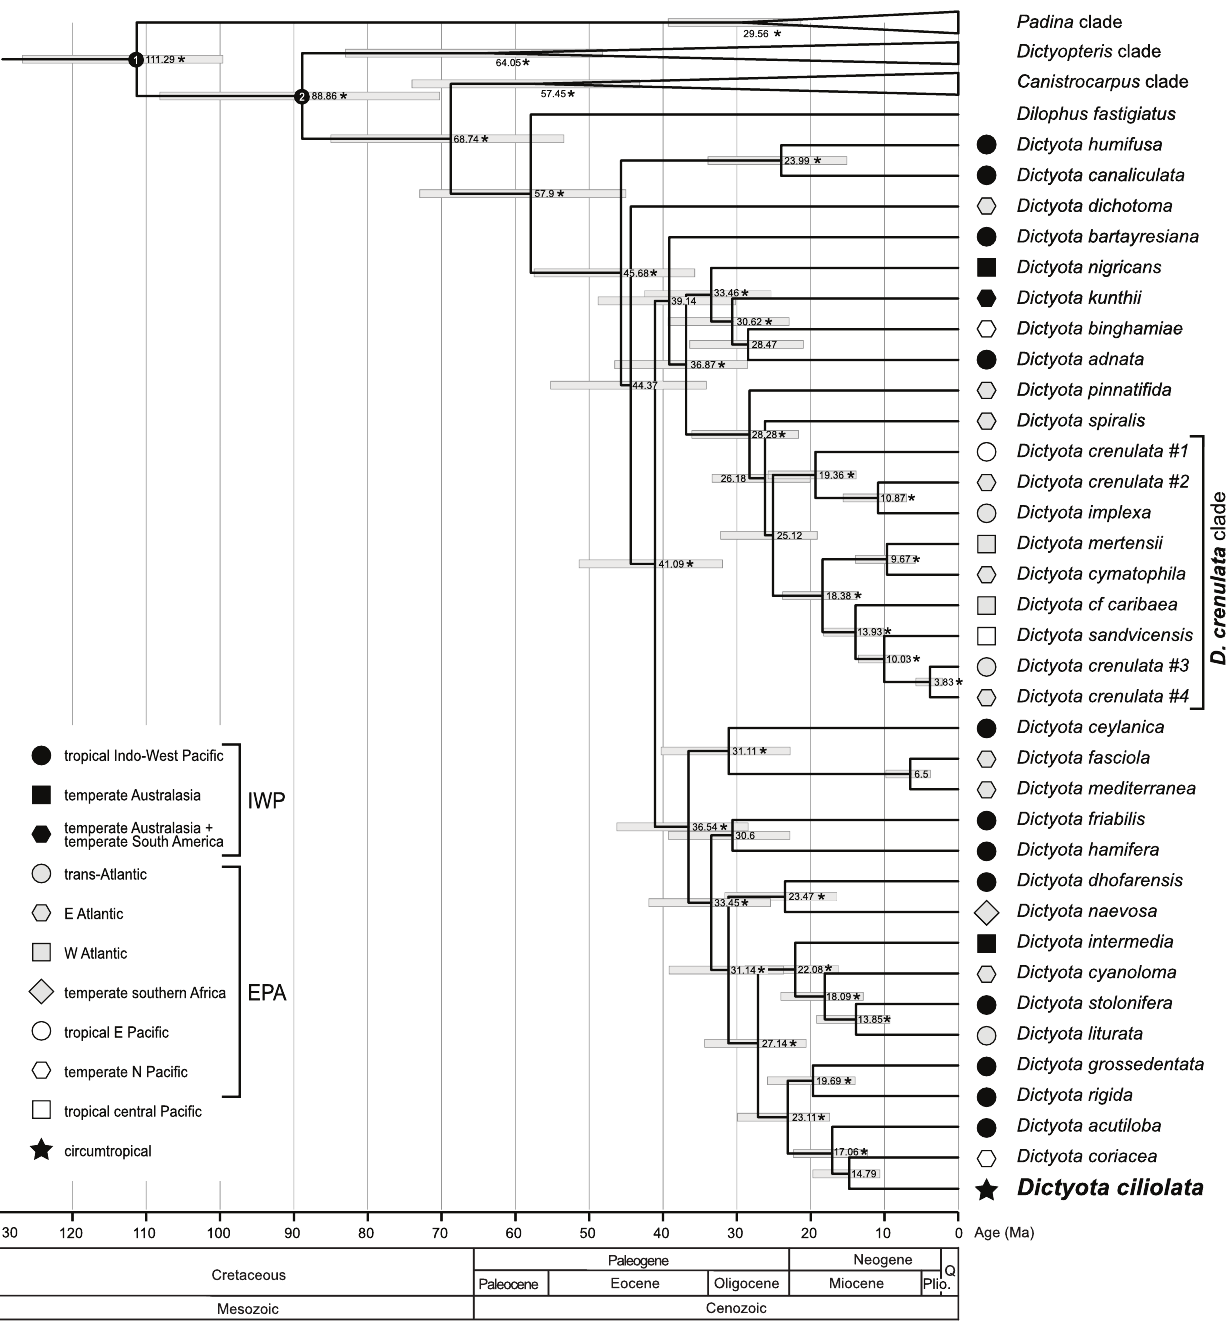
Figure 2. Time-calibrated phylogeny. Highest density probability (95% HPD) intervals are provided for each node as well as the posterior probabilities, stars represent strong support (p.p. . 0.95). doi:10.1371/journal.pone.0030813.g002 Species distribution ranges and thermal tolerance Dictyota species varied widely in their latitudinal as well as longitudinal range (Table 2). Mean values of thermal tolerance ranged from 21.1 u C in D. implexa to 28.5 u C in Dictyota cf. caribaea . Differences in maximum and minimum values of SST between species were more pronounced, which were also shown by these two species (31 u C in Dictyota cf. caribaea and 17.1 u C in D. implexa ). Significant correlations were detected between maximum thermal tolerance range ( u C) and latitudinal range (R 2 = 0.751), and